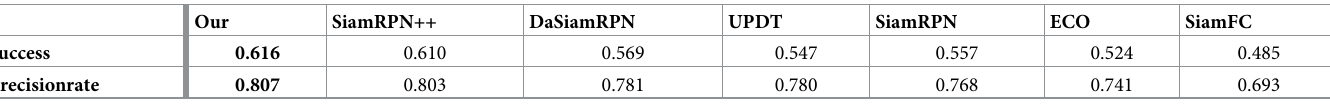
Table 4. Comparison with other competitive methods on the test split of UAV123 in terms of success rate and precision rates. Our SiamRPN++ DaSiamRPN UPDT SiamRPN ECO SiamFC Success 0.616 0.610 0.569 0.547 0.557 0.524 0.485 Precisionrate